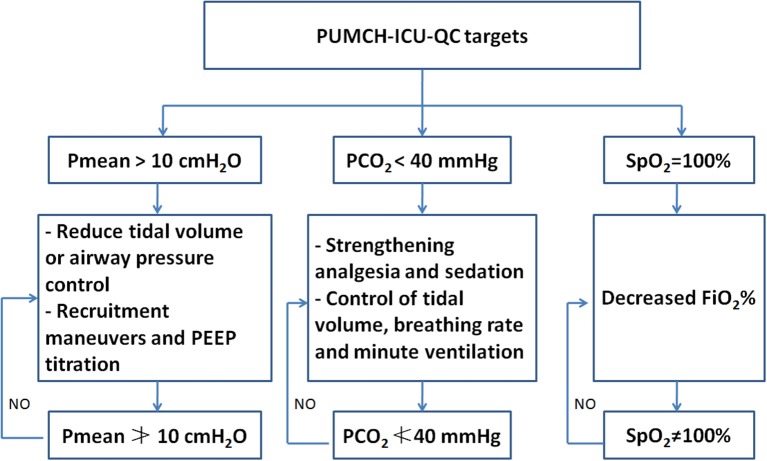
The brief description of the strategy and protocol used to adjust SpO2, PaCO2, and Pmean. PUMCH, Peking Union Medical College Hospital; ICU, intensive care unit; QC, quality control.